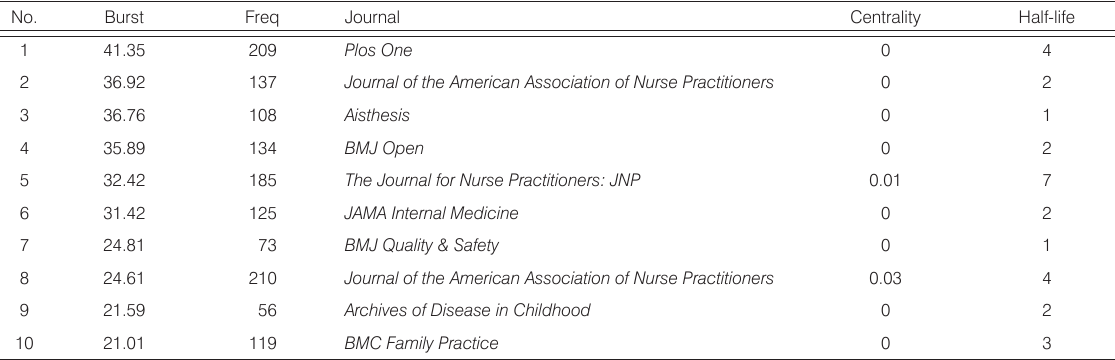
Table 5. The top 10 co-cited journals of NPs according to the strength of burst.